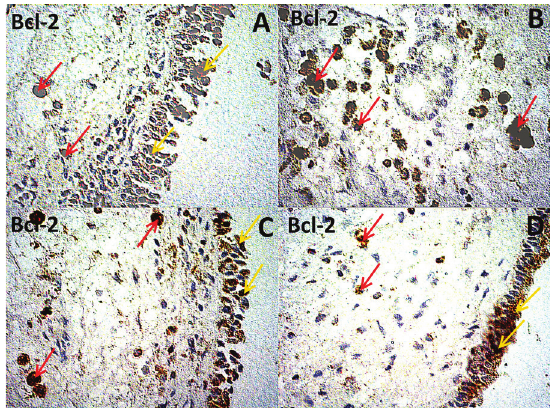
Figure 2 - Immunostaining for Bcl-2 in patients with CRSsNP. Strong staining is found in nasal epithelial cells. The number of Bcl-2-labelled nasal epitheliocytes is much higher compared with the control group (A, C, D; yellow arrows). Atrophic regions were characterized with a lower number of Bcl-2 positive cells in the lamina propria (D; red arrows). Bcl-2 expression was week in the glandular epithelial cells in regions with no signs of damage (B). In some regions, extracellular matrix cells strongly expressed Bcl-2 (B; red arrows). Figures 2a, 2c, 2d - 100x; Figure 2b –